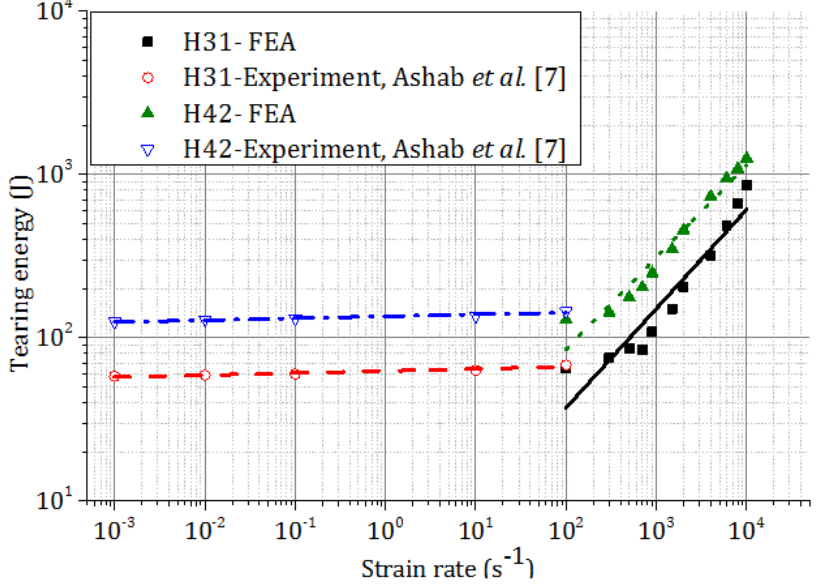
Figure 11. Effect of strain rate on the tearing energy of different honeycombs. Materials 2016 , 9 , 162